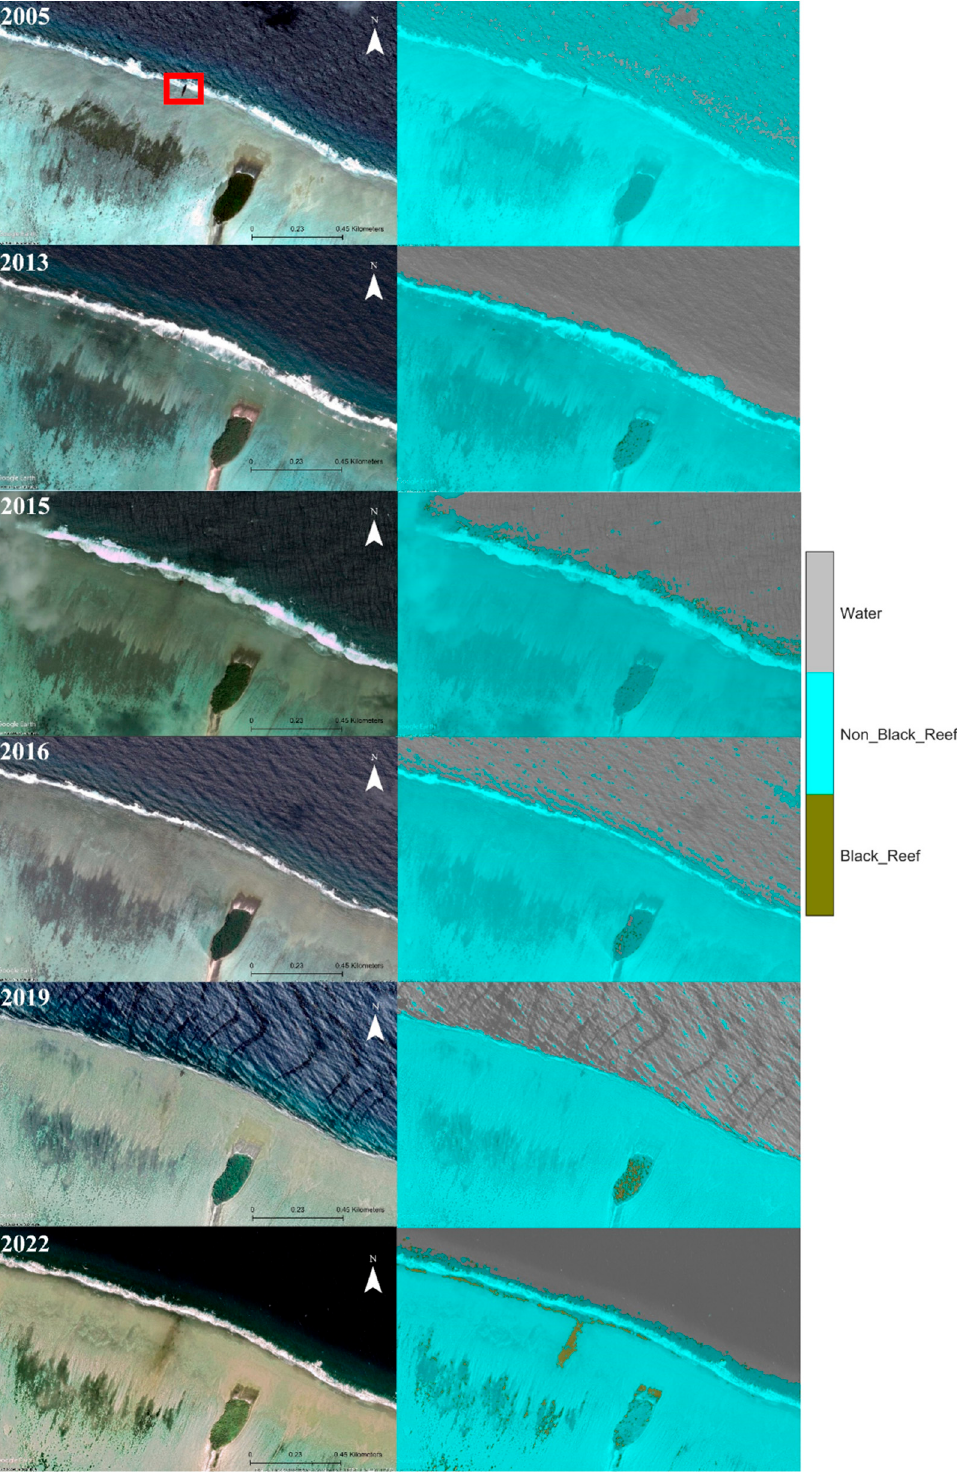
Figure 11. ( Left ) column: All available Google Earth images from the Kwajalein reef for the years 2005, 2013, 2015, 2016, 2019 & 2022, inside the red rectangle is the location of the shipwreck. ( Right ) column: the corresponding segmented images.